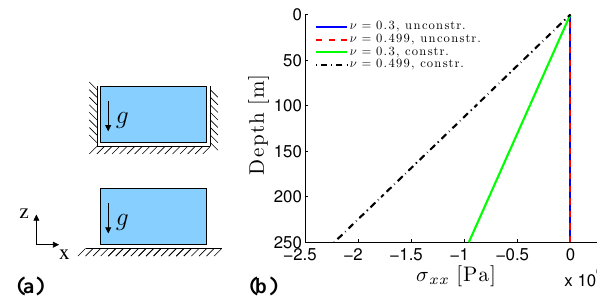
Fig. 3. (a) Uncracked model for the evaluation of proper BCs, with constrained (upper geometry) and unconstrained (lower geometry) vertical boundaries. (b) Normal stress σ xx for the uncracked